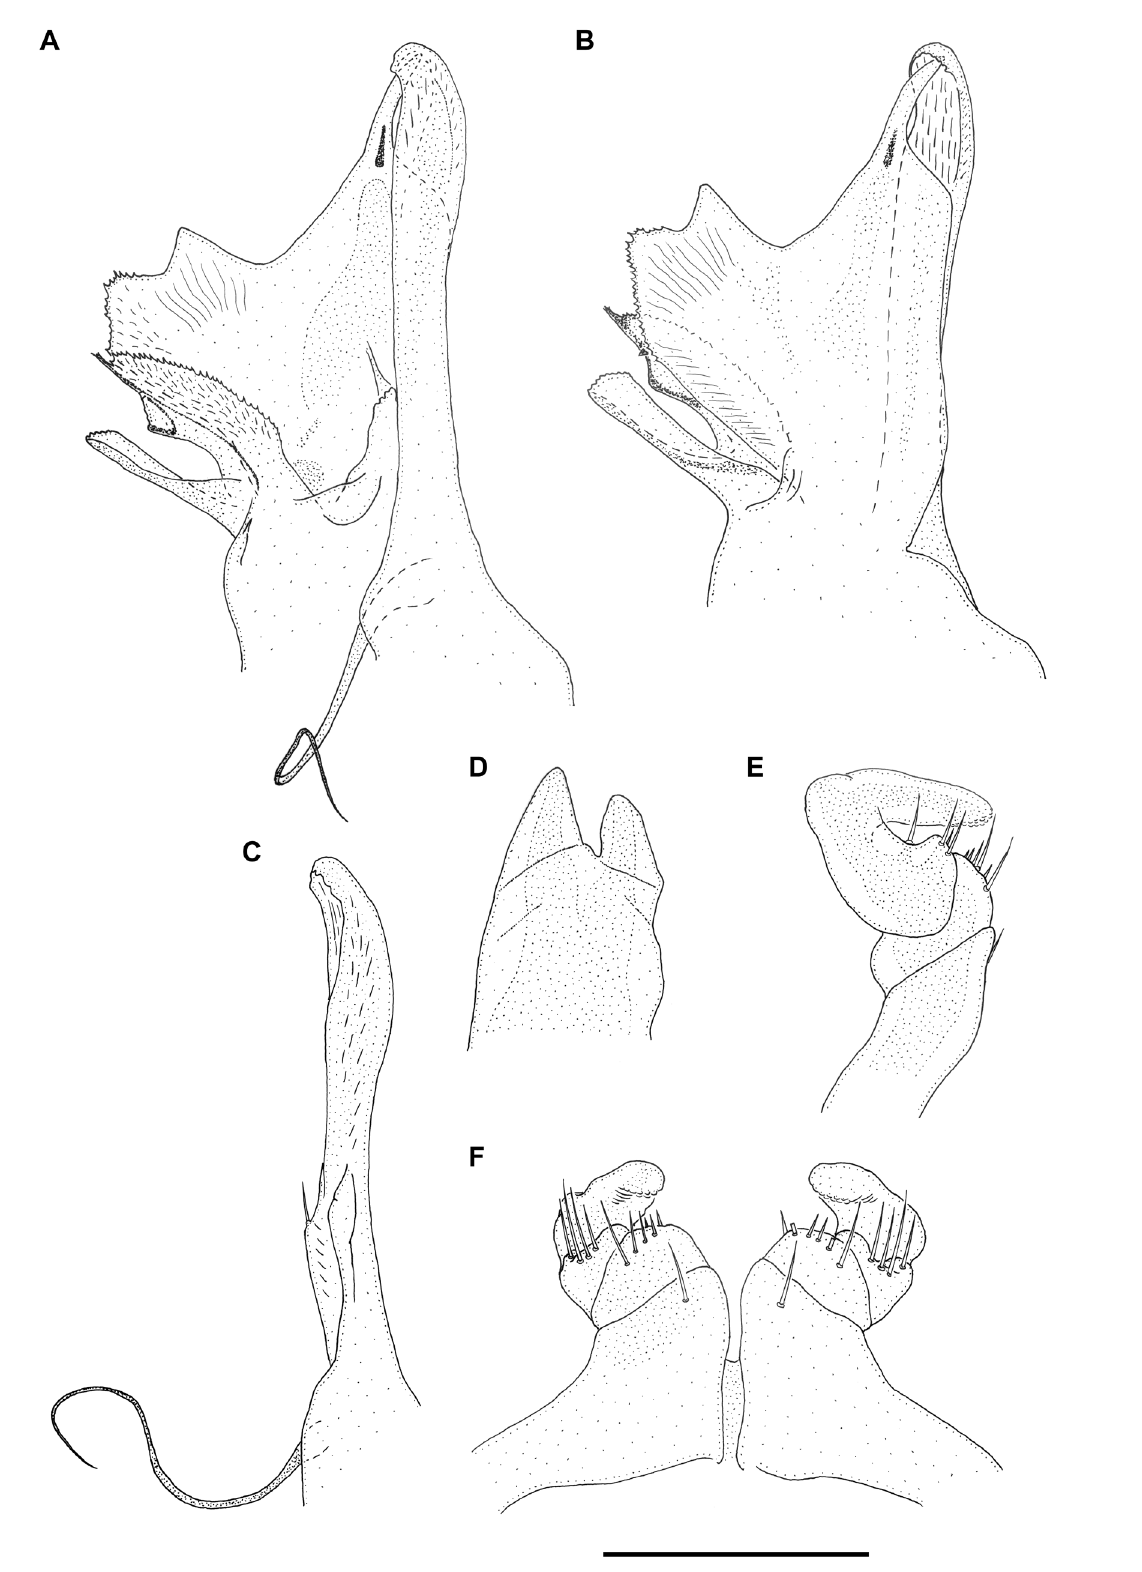
Fig. 28. Leucogeorgia lobata sp. nov., paratype ♂ from Garakha Cave (IZISU). A . Right gonopods, mesal view. B . Left gonopods, lateral view. C . Left promere, lateral view. D . Penes, posterior view. E . Left leg 1, lateral view. F . Leg-pair 1, anterior view. Scale bar: 0.3